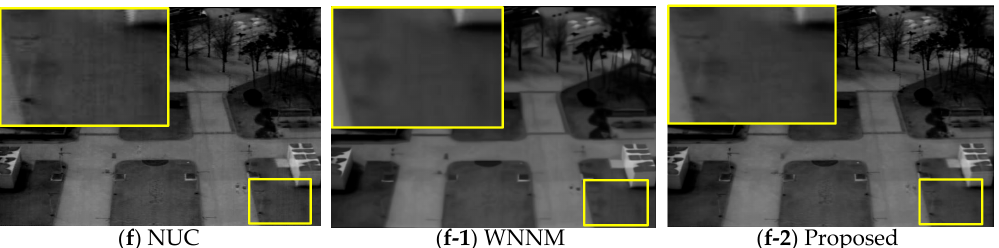
Figure 10. NUC, WNNM, and proposed the BRANF applied on MWIR and LWIR images with various types of noise: ( a , b ) flickering lines and dots; ( c ) vertical oblique lines; ( d , e ) wavefront aberration; ( f ) LTV line noise. (Experimental data set 1).